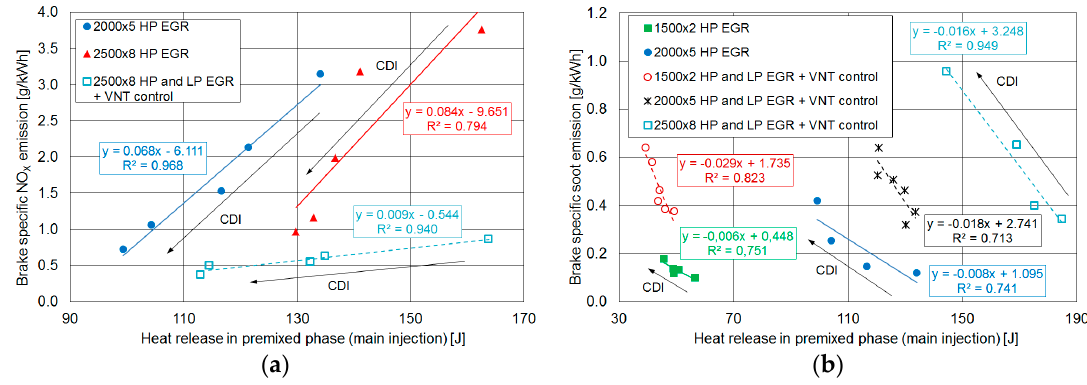
Figure 10. Link between heat released in premixed phase and brake specific emissions (NO X ( a ) and soot ( b )) in different test sets.